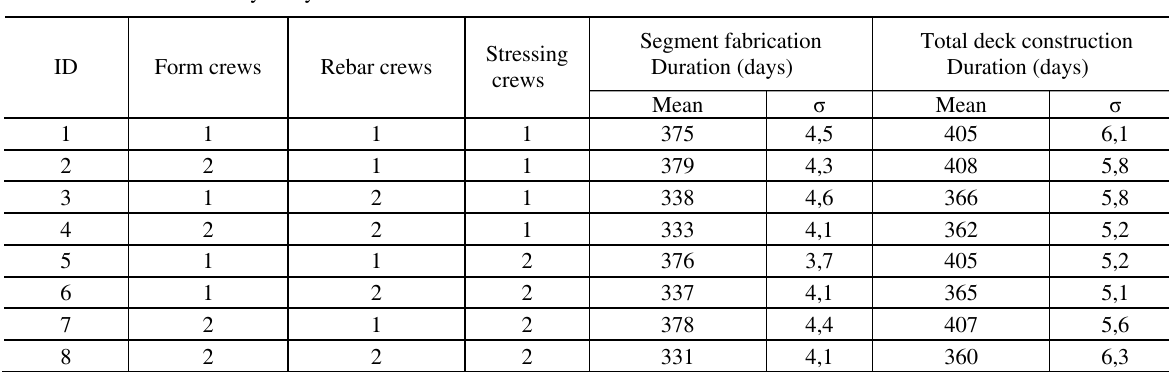
Table 7 . Results of sensitivity